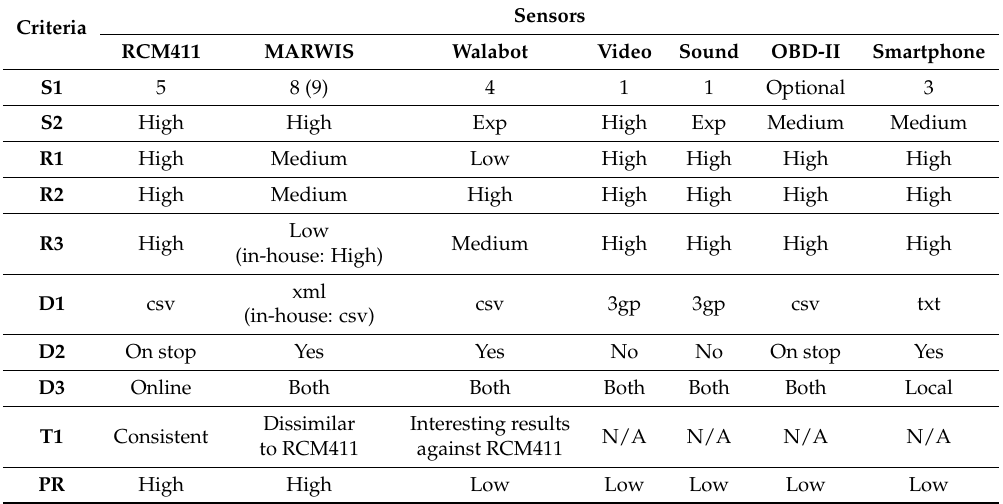
Table 2. Results of the criteria evaluation described in Table 1, along with the price range (PR) of each